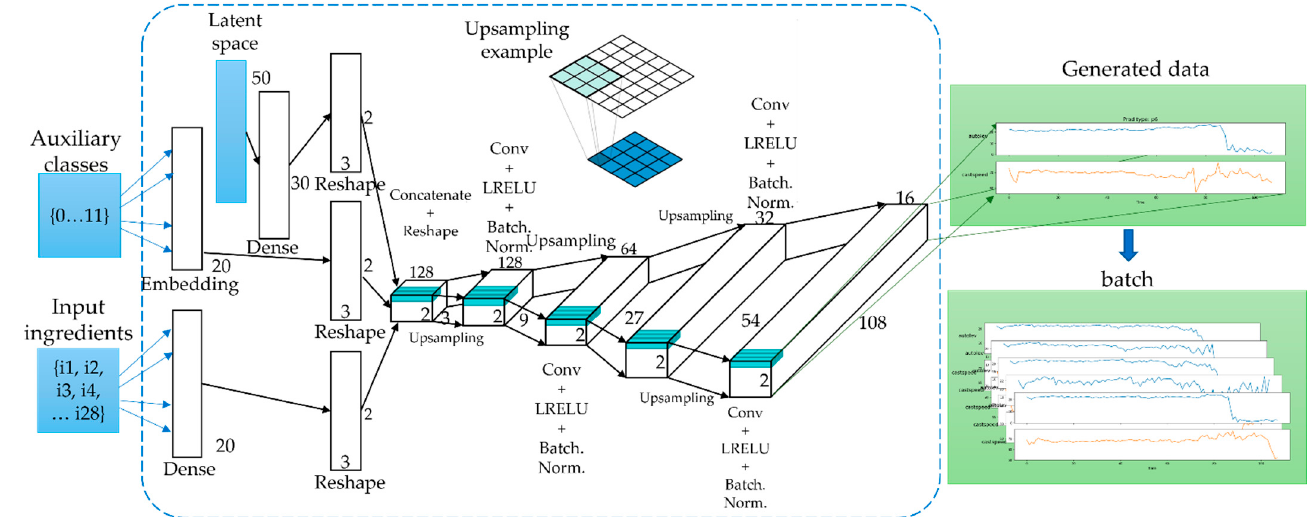
Figure A3. Implementation details of the generator model for the casting process.